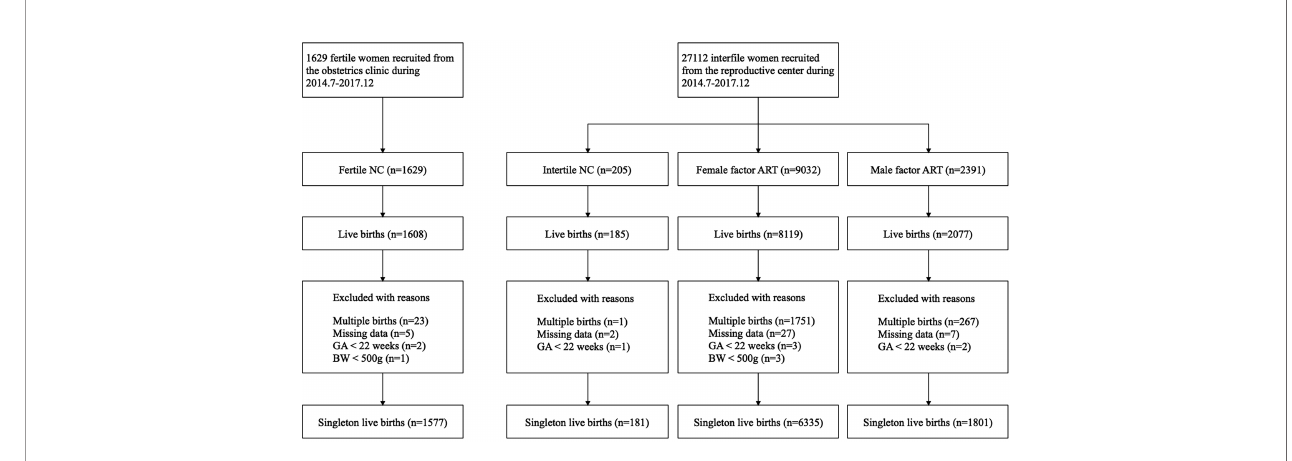
FIGURE 1 | Participants in